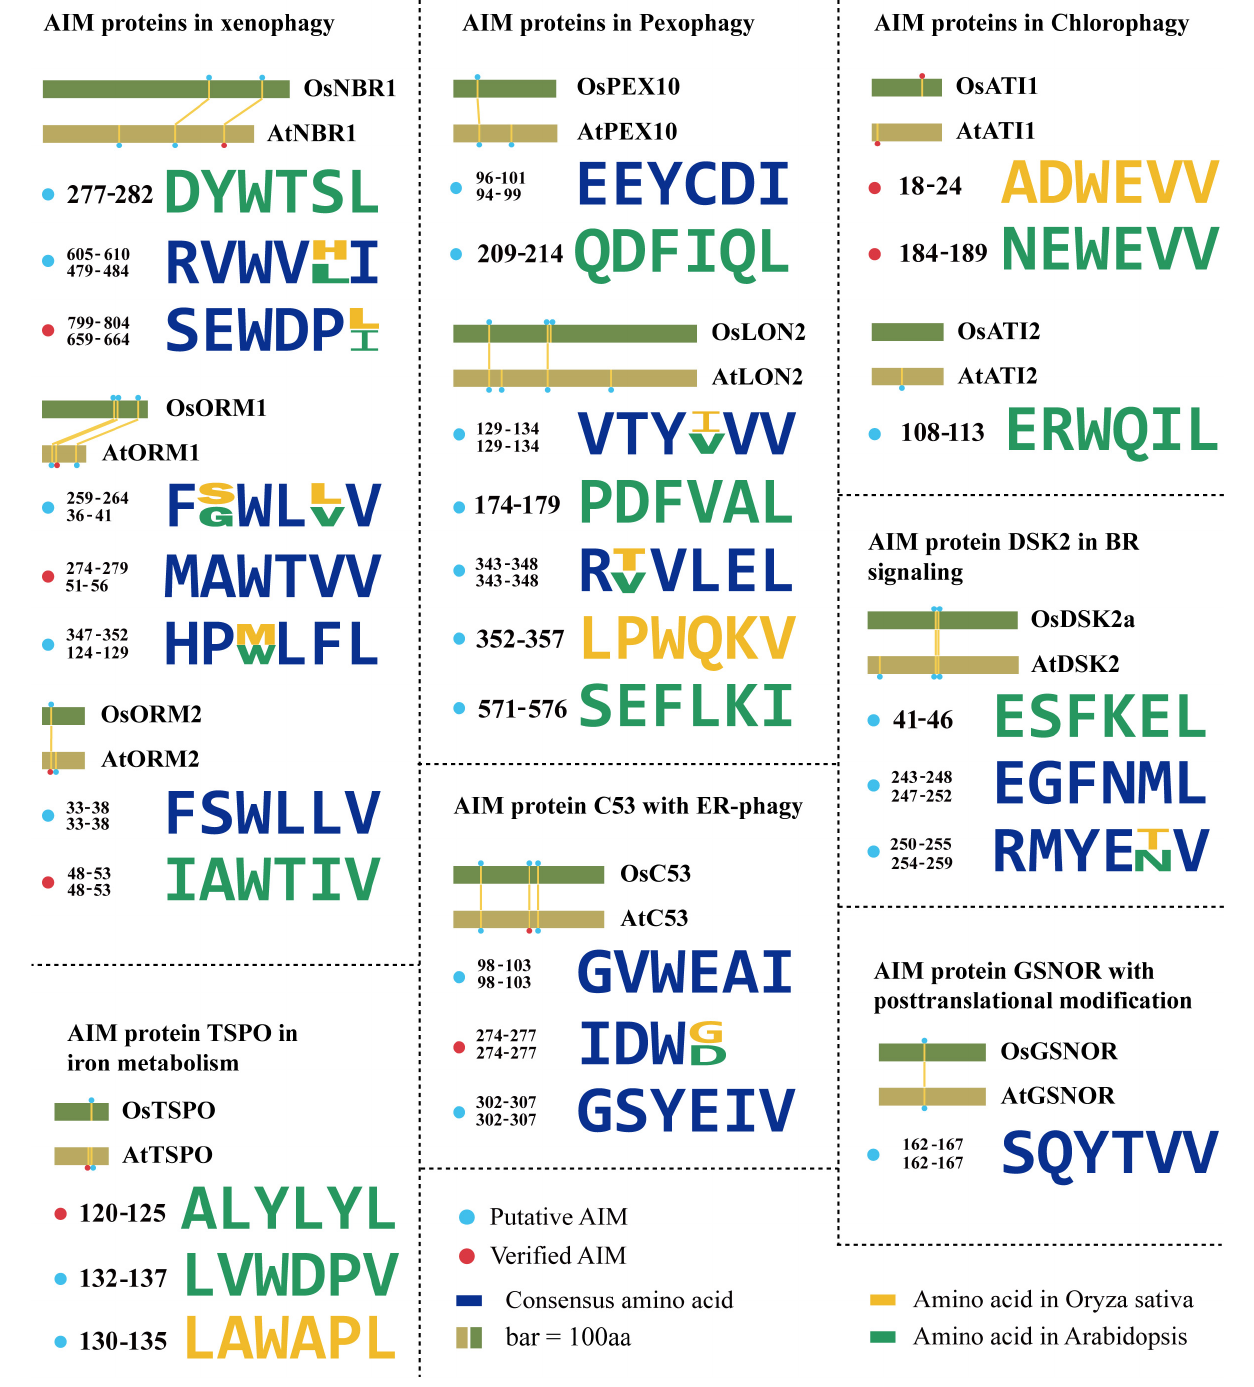
FIGURE 2 | The evolution of AIMs derived from the known ATG8-interacting proteins in plants. Degenerate sequences of AIMs of known ATG8-interacting proteins by which AIMs in Arabidopsis thaliana and Oryza sativa are shown in yellow and green, respectively. Blue sequences are consensus amino acids of AIMs in both species. The rice AIM containing proteins are derived from alignments of Arabidopsis proteins known to interact with ATG8 from the NCBI database (https://blast.ncbi.nlm.nih.gov/). AtNBR1 (Q9SB64.1), OsNBR1 (KAF2945618.1), AtORM1 (NP_563622.1), OsORM1 (XP_015627600.1), AtORM2 (NP_199015.1), OsORM2 (XP_015637165.1), AtDSK2 (NP_565407.1), OsDSK2 (XP_015614223.1), AtPEX10 (NP_001323820.1), OsPEX10 (BAG87060.1), AtPEX6 (NP_171799.2), OsPEX6 (XP_015634963.1), AtLON2 (NP_568675.1), OsLON2 (BAD33324.1), AtC53 (NP_196301.2), OsC53 (XP_015644258.1), AtATI1 (NP_566059.1), OsATI1 (NP_001052131.1), AtATI2 (NP_567174.1), OsATI2 (NP_001048554.1), AtGSNOR (NP_001190468.1), OsGSNOR (XP_015627169.1), AtTSPO (NP_566110.1), OsTSPO (XP_015639220.1).